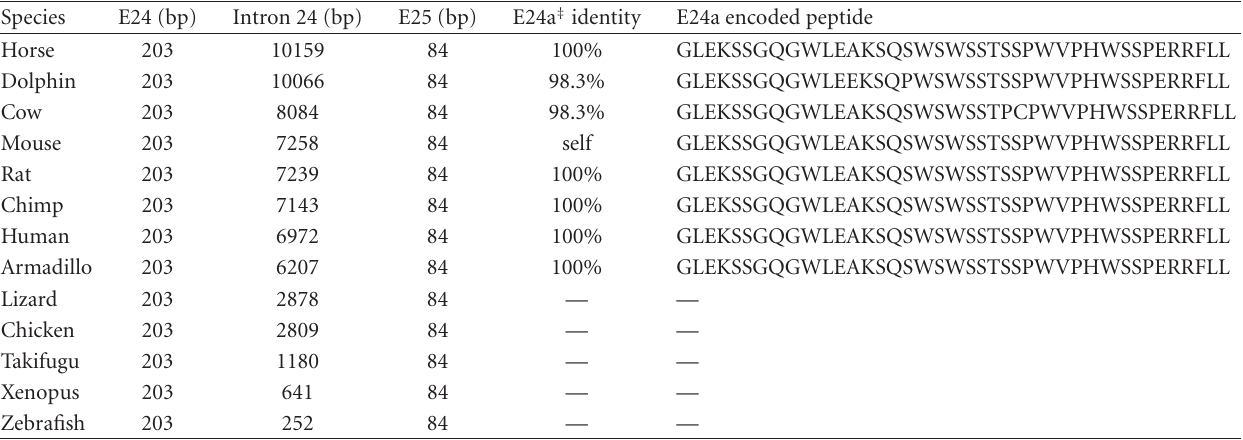
Table 1: CASK E24a is associated with peptide coding capacity in